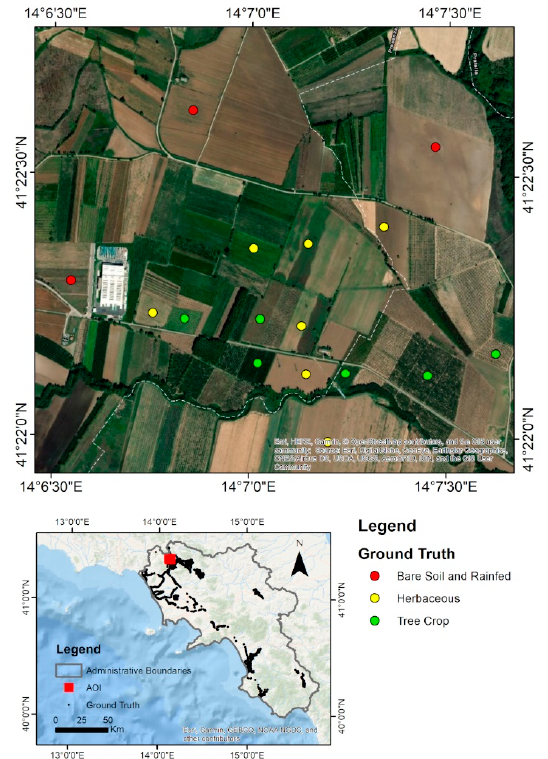
Figure 8. Example of ground truth samples acquired in an agricultural area in northern Campania and spanning multiple